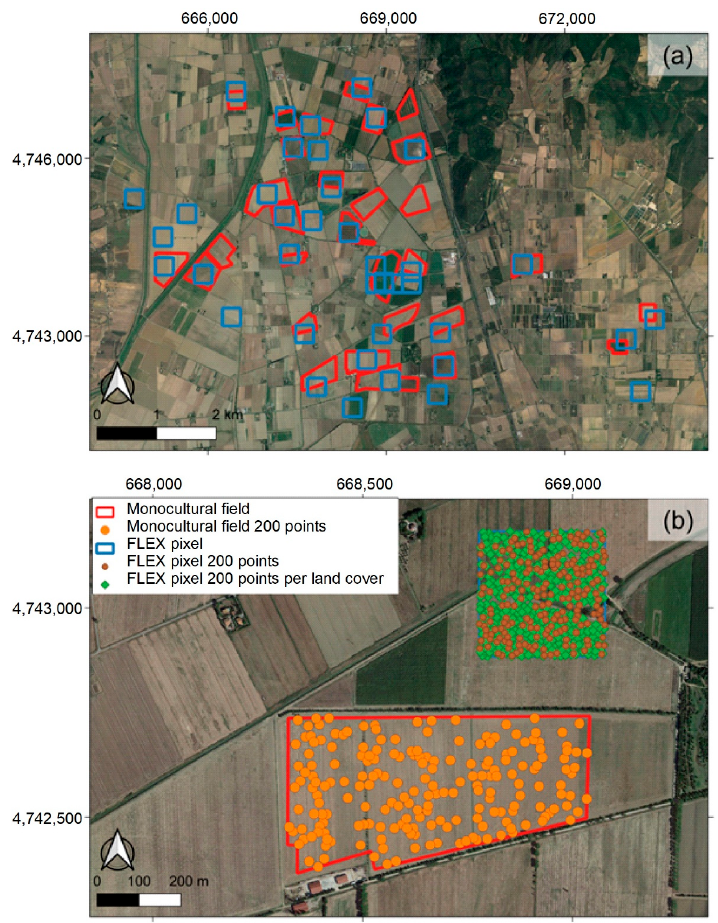
Figure 1. Monocultural fields and FLEX pixels considered in the Braccagni study area ( a ). Example of the realization of 200 fully random points within a monocultural field (orange dots) and within a hypothetical FLEX pixel (brown dots). Green diamonds show the 200 fully random points selected for each land cover in a FLEX pixel composed of two different components ( b ). The map projection is Universal Transverse of Mercator (UTM) zone 32N with datum WGS84 (World Geodetic System 1984). For the Braccagni experimental site, a total of 39 FLEX pixels were identified. Among them, 18 are ‘pure’ pixels, meaning that they include only one component; 6 include two components; 11 comprise three components; and 4 have four components. For the Selhausen experimental site, a total of 11 FLEX pixels were placed: three with two components, six with three components and two with four components. The Braccagni and Selhausen areas have different characteristics, with Braccagni characterised by broad fields, allowing for the realization of one-component reference areas, whereas Selhausen